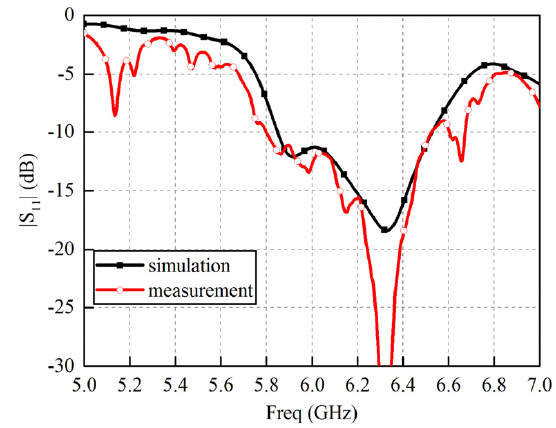
Figure 9. Simulated and measured reflection coefficients for the proposed FPRA.